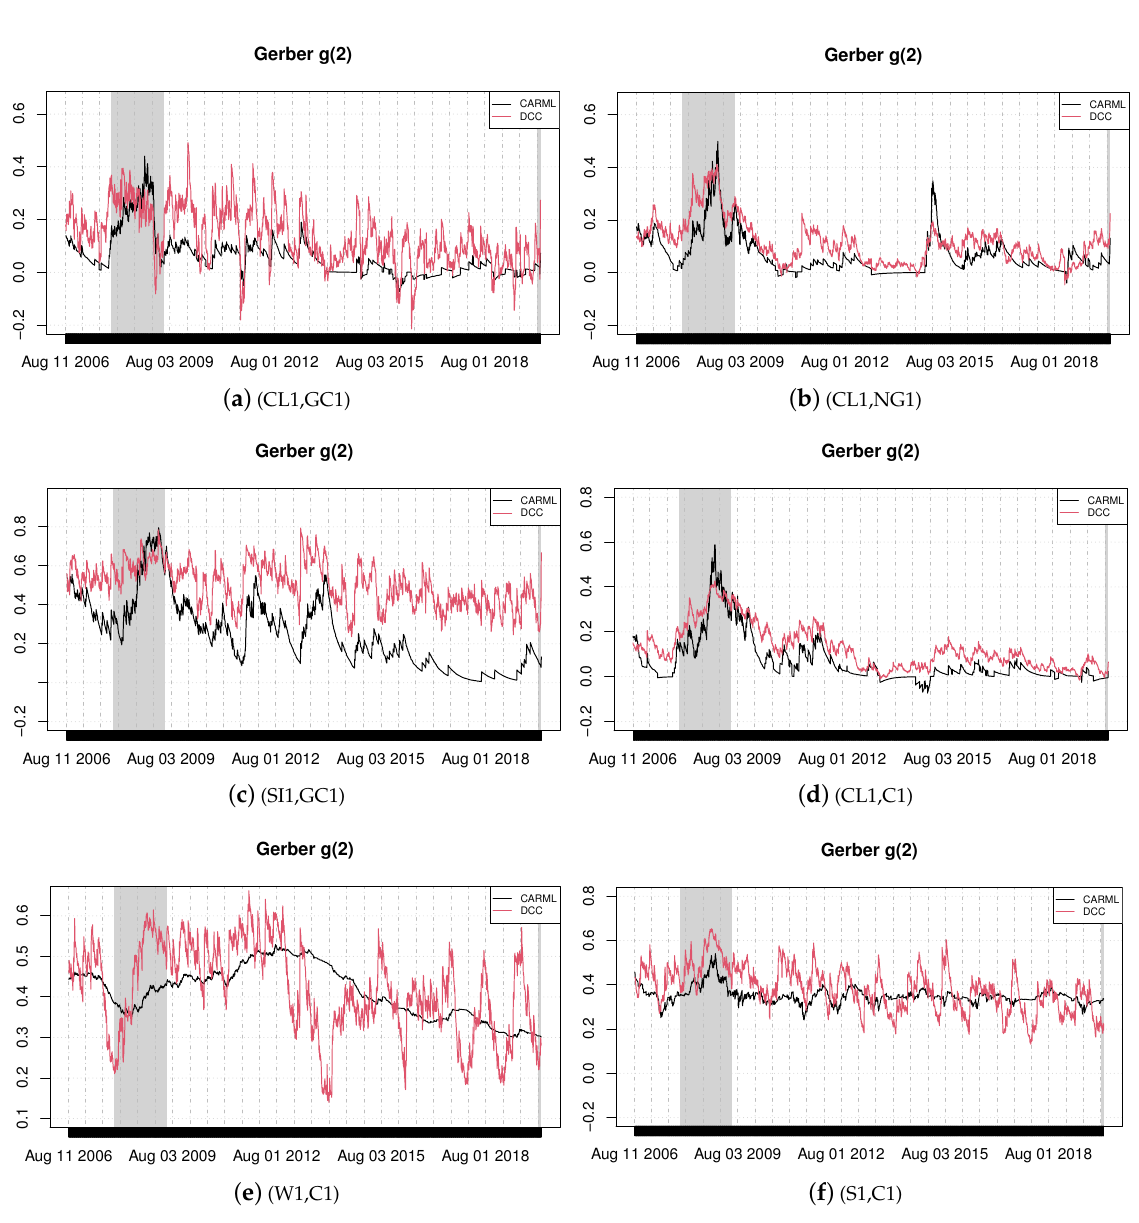
Figure 2. Time-varying Gerber correlations, Equation (3). Thresholds are Q i = q i ( 90% ) and Q j = q j ( 90% ) where q i ( 90% ) and q j ( 90% ) are the (unconditional) 90% quantiles of the